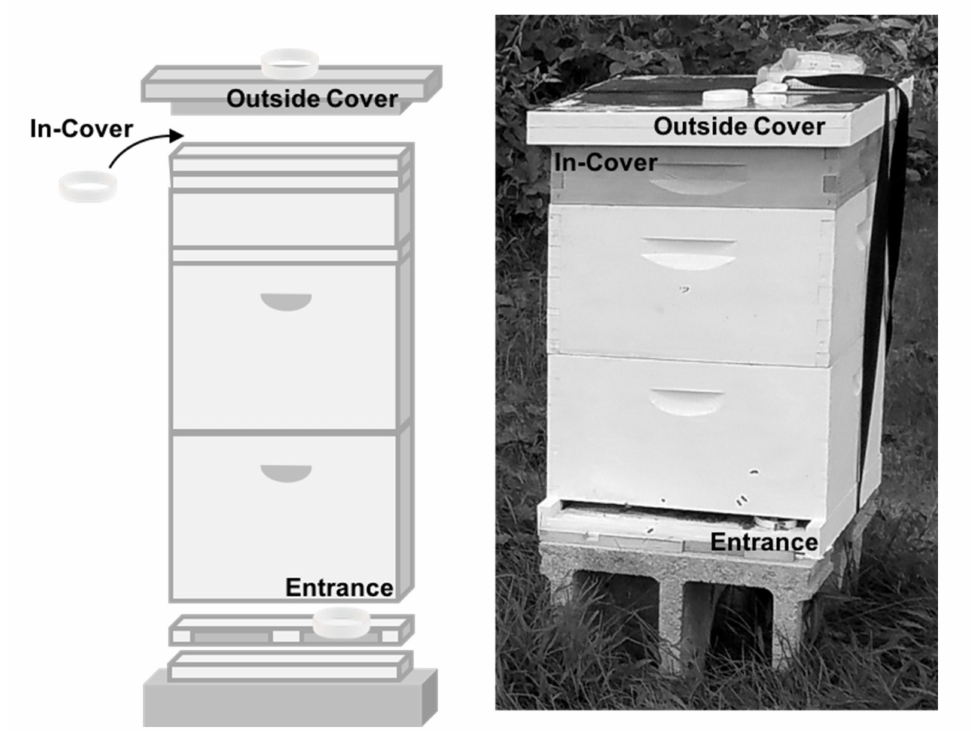
Figure 1. Diagram of a hive ( left ) and photo of a hive in the field ( right ), highlighting the placement of bands. In-cover band for the hive in the field is not shown as it is inside the cover part of the hive. Wristbands shown are 20 cm in circumference and 1 cm width; hives are approximately 1 × 0.5 × 0.4